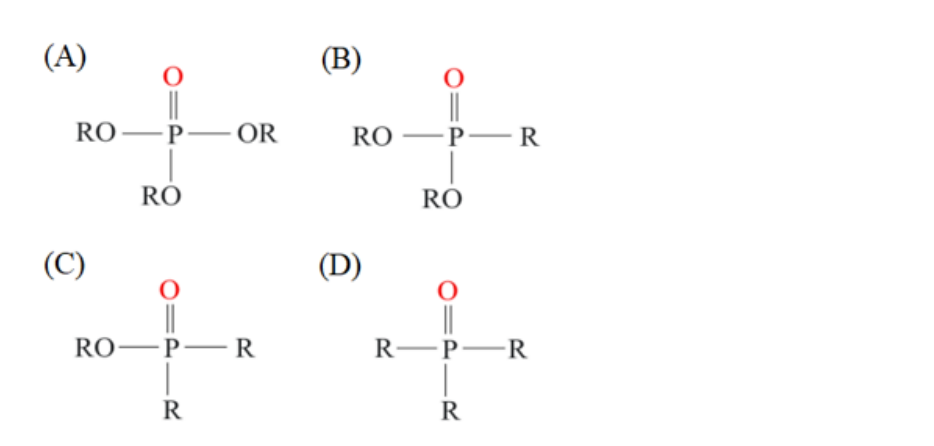
Figure 4. Chemical structure of solvating extractants based on phosphorus: ( A )—phosphate, ( B )— phosphonate, ( C )—phosphinate, and ( D )—phosphine oxide, adapted from [2,9].